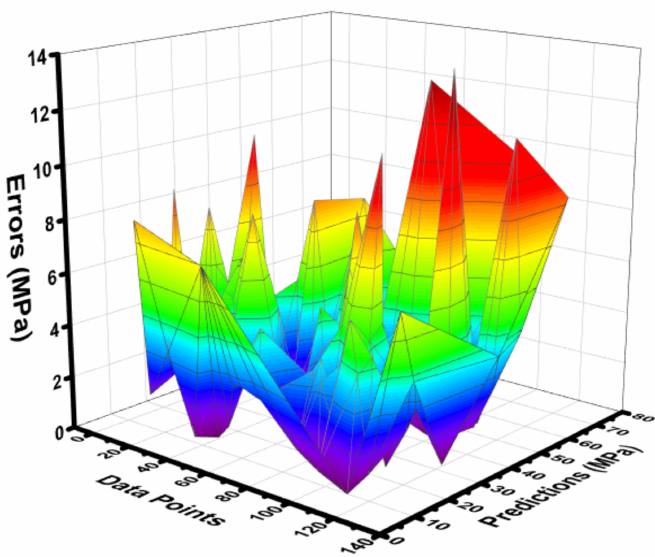
Figure 8. Difference between the experimental C-S and predicted C-S of the DT model.